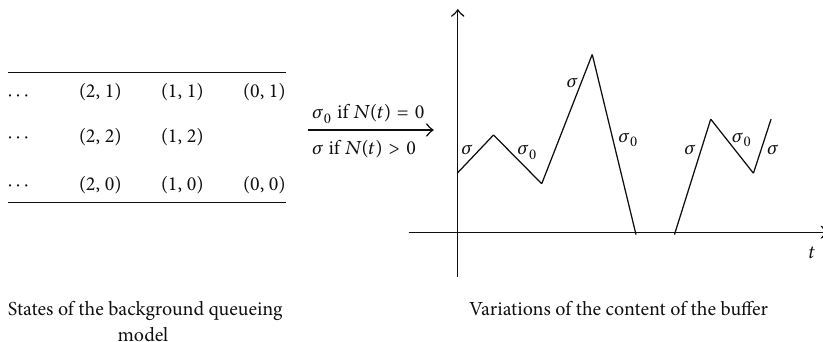
Figure 2: Interaction between fluid model and the background queueing